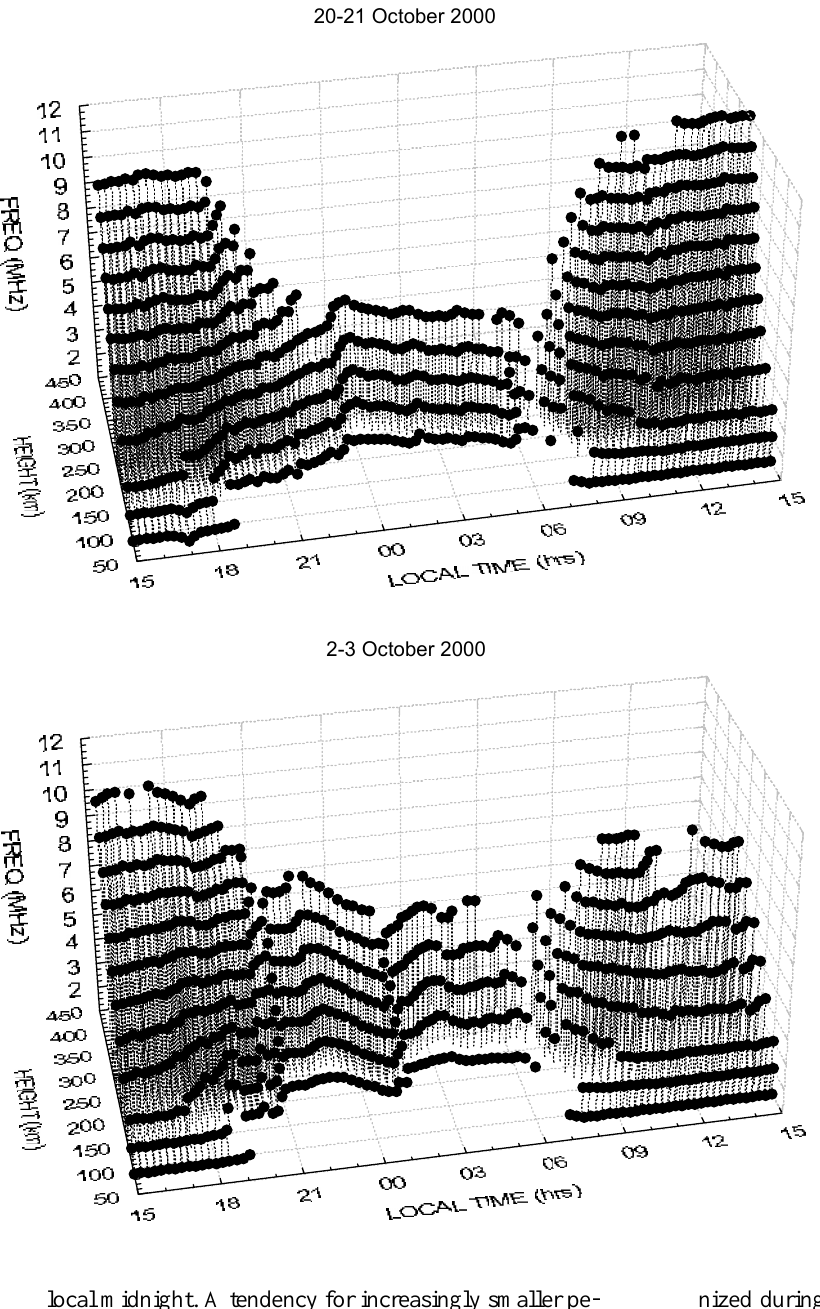
Fig. 5. The 3-D plot of the height vari- ation for plasma frequencies 2–12MHz versus the local time for the night hours between 2 and 3 October 2000. Ioni- sation enhancement was observed over